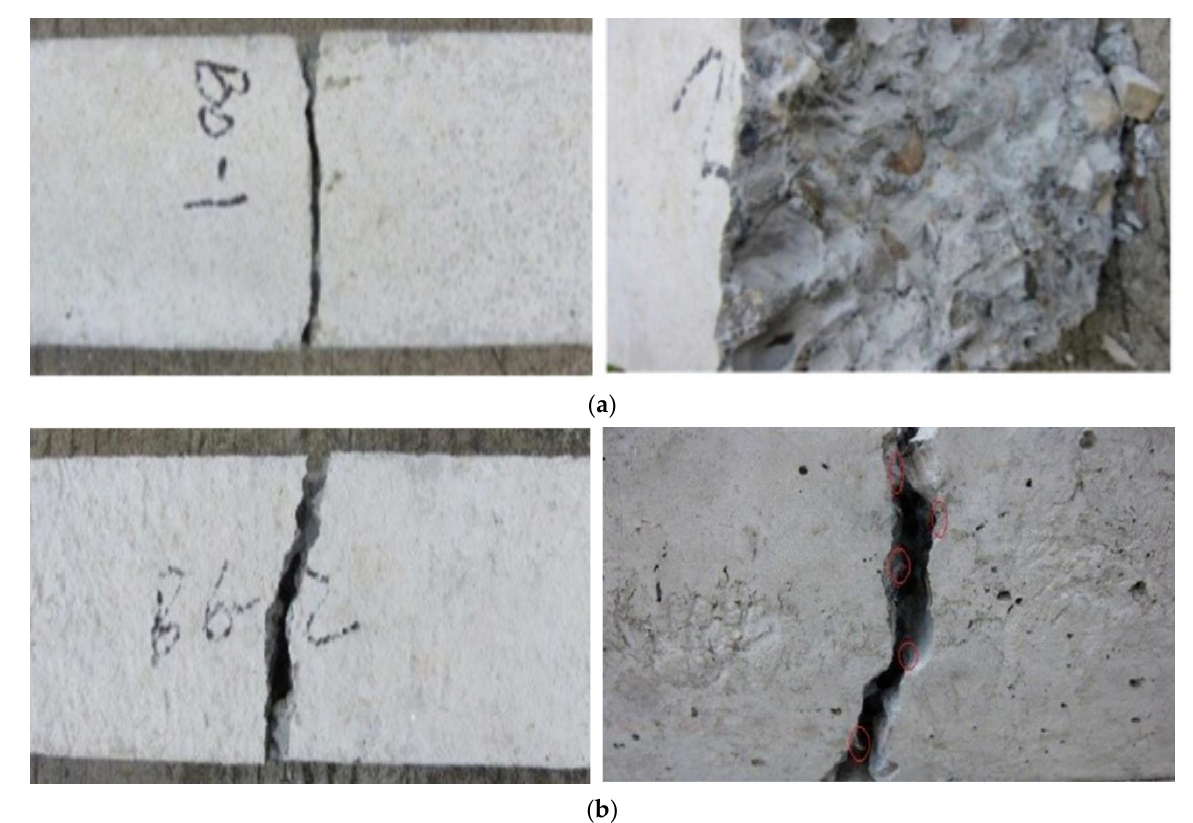
Figure 10. Tensile Failure Mode ( a ) Control and ( b ) Basalt Fiber Reinforced [78].